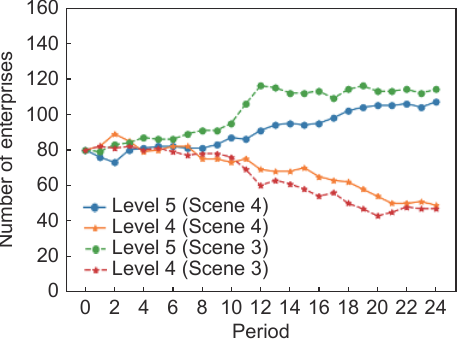
Fig. 15 Scenes 3 and 4: Changes of number of enterprises in Levels 4 and